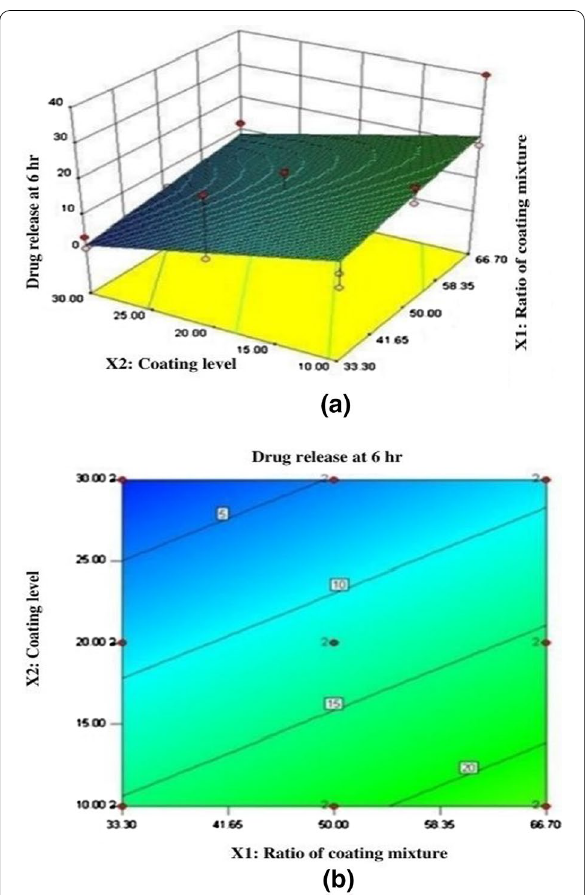
Fig. 5 Response surface method analysis for (Table 2) Y 2 [ a response surface plot & b response contour